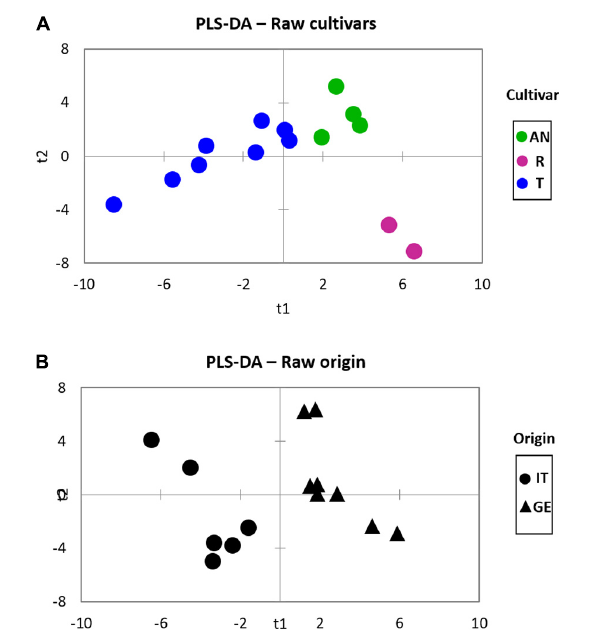
FIGURE 2 | The partial least square discriminant analysis (PLS-DA) of Tonda Gentile Trilobata , Tonda Gentile Romana , and Anakliuri samples harvested in Italy and Georgia focusing on (A) cultivar and (B) origin on raw